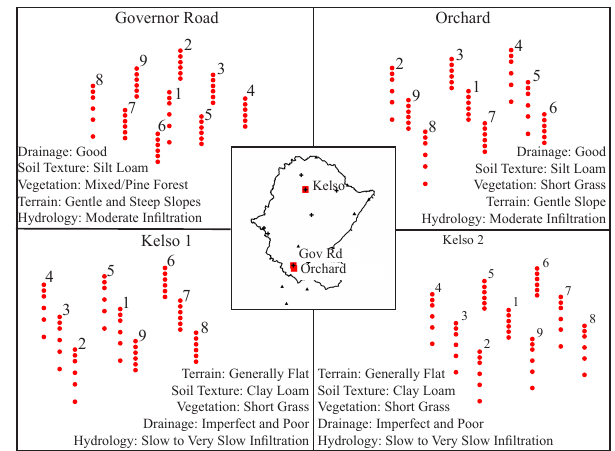
Fig. 3. Three dimensional schematic representation of the McMas- ter Mesonet. Note: the vertical dimensions are to scale, whereas spa- tial dimensions are not (see Fig. 4). The symbols in the centre map are consistent with Fig.